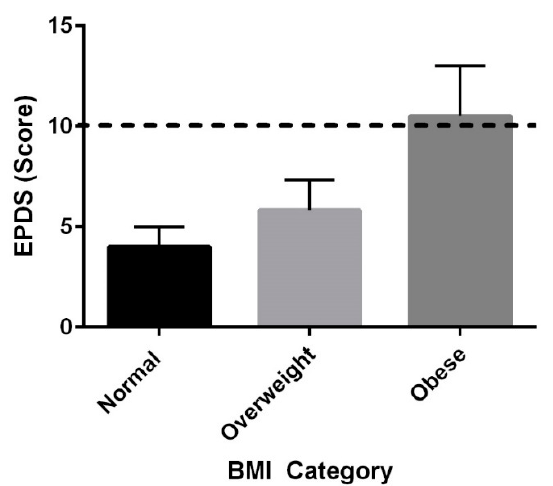
Figure 2. Mean ± SE EPDS Scores at Six Months Postpartum between pre-pregnancy BMI categories;